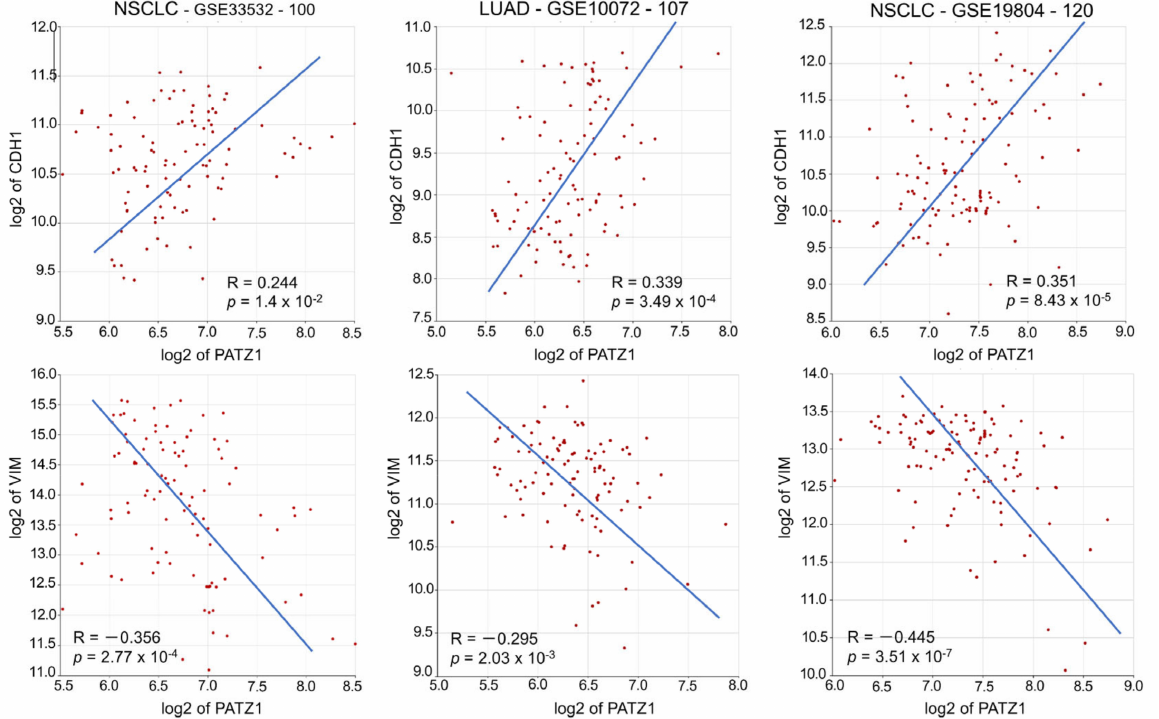
Figure 7. PATZ1 negatively correlates with EMT in NSCLC. XY-dot plots showing the correlation between PATZ1 ( X -axis) and CDH1 ( Y -axis) or VIM ( Y -axis) gene expression in three publicly available gene expression NSCLC datasets analyzed via the R2: Genomic Analysis and Visualization platform